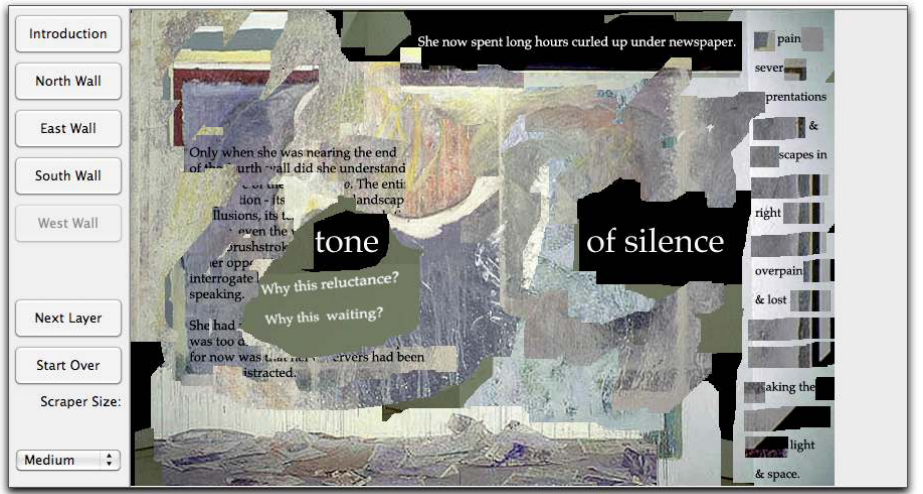
Jerome Fletcher, Geoffrey Olsen, Toby